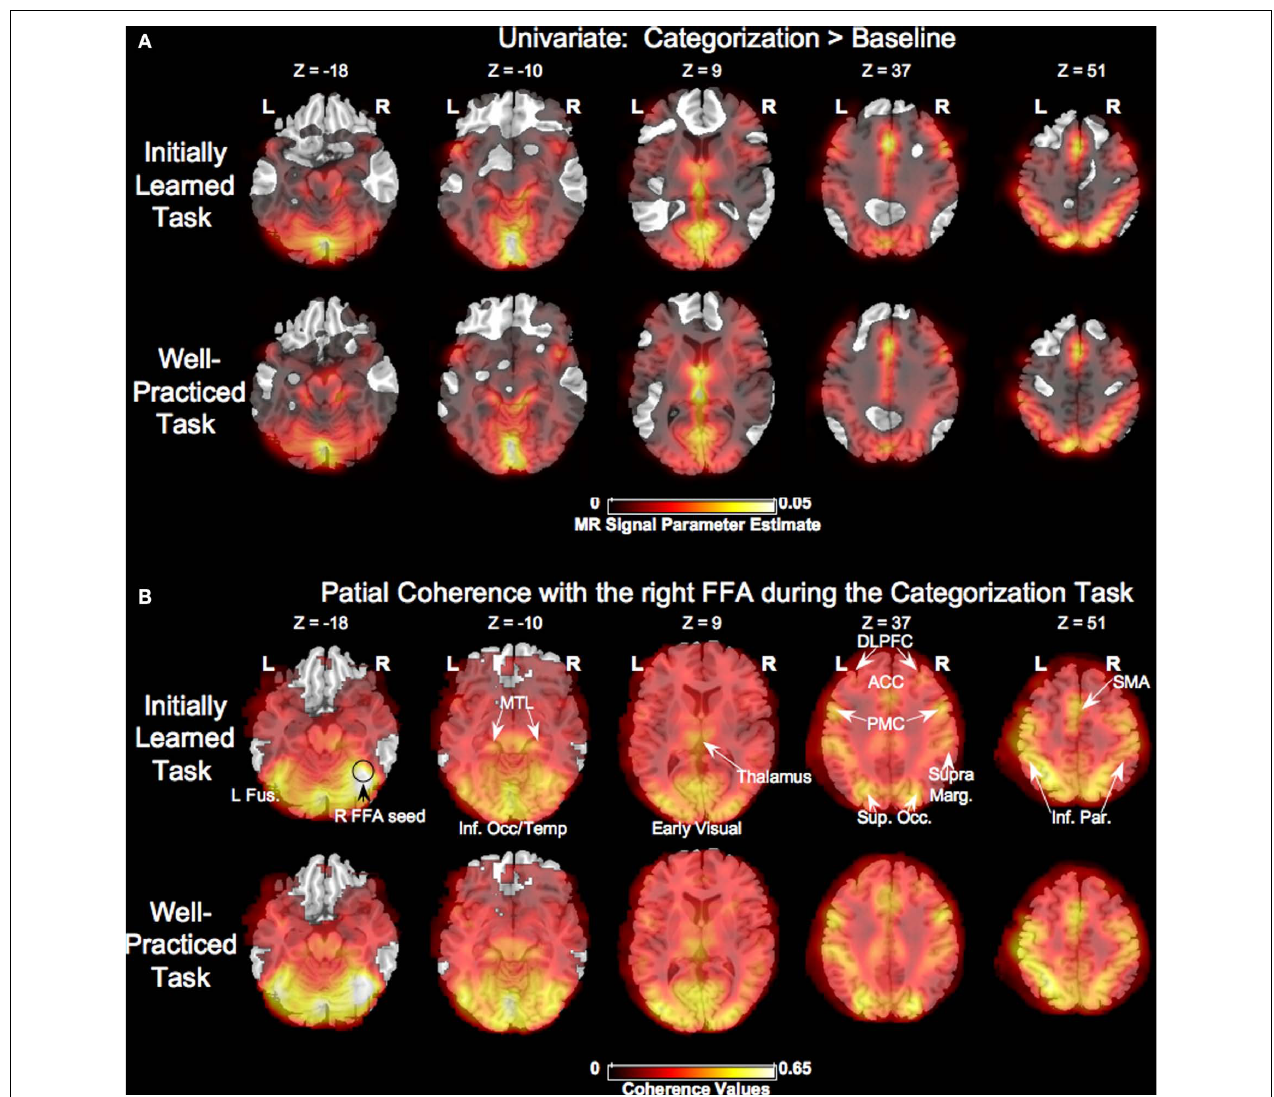
conditions. L Fus. = left fusiform, R FFA = right fusiform face area, MTL = medial temporal lobe, Inf. Occ/Temp = inferior occipital/temporal lobe, DLPFC = dorsolateral prefrontal cortex, ACC = anterior cingulated, PMC = premotor cortex, SupraMarg. = supramarginal gyrus, Sup. Occ. = superior occipital gyrus, SMA = supplementary motor area, Inf. Par. = inferior